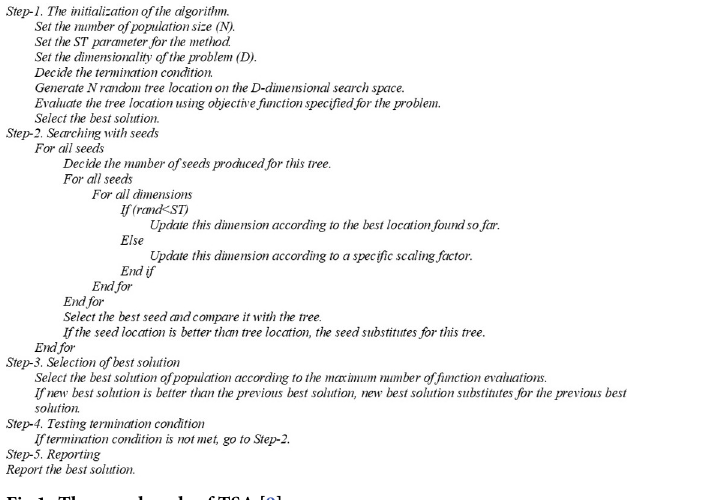
Fig 1. The pseudocode of TSA